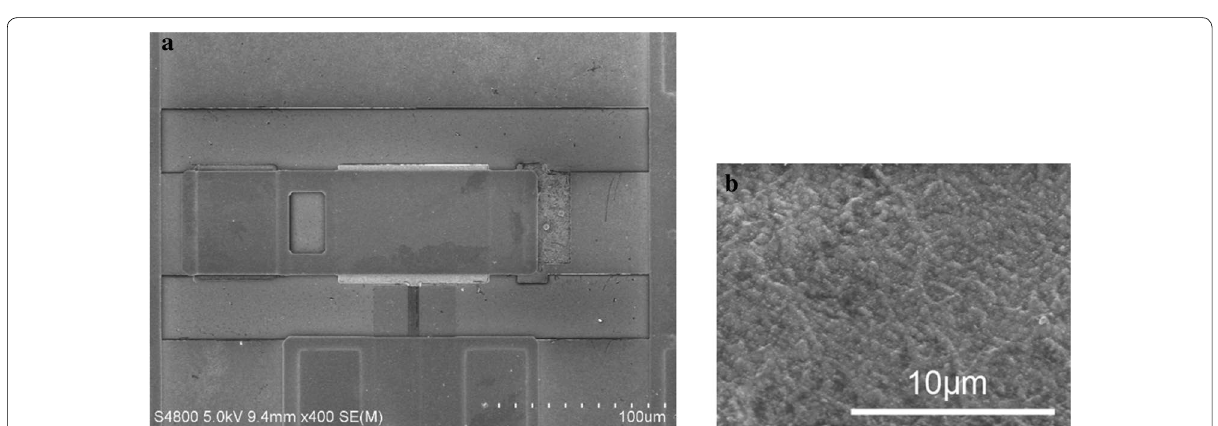
Fig. 4 SEM images of fabricated Au–Au/CNT‑composite layer contact RF‑MEMS switch: a a top‑view of the switch, b a magnified view of the Au/ CNT‑composite layer